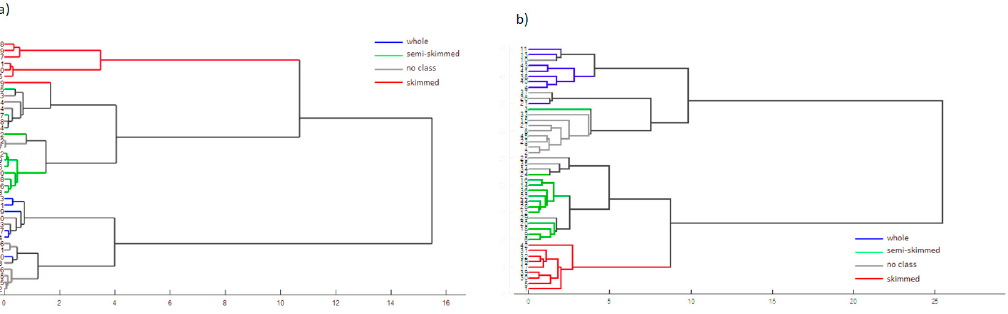
Figure 3. ( a ) Dendrogram for the SCiO fat data and ( b ) the dendrogram for the NeoSpectra fat